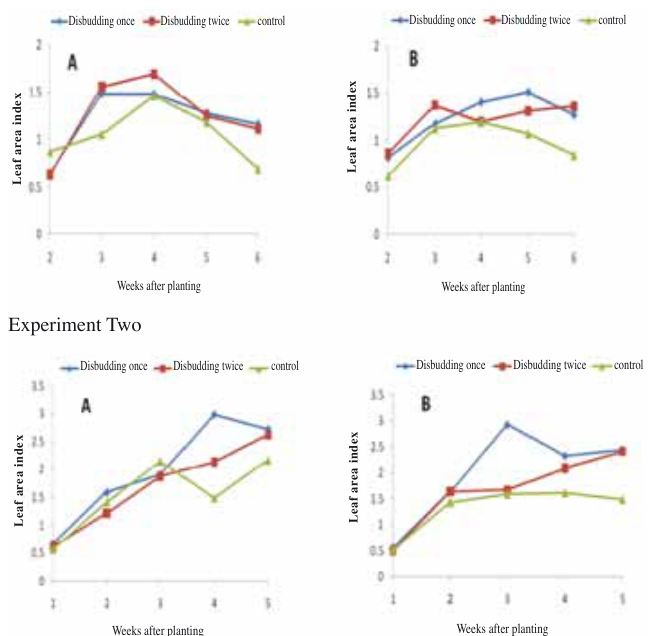
Fig. 3 - Leaf area index as affected by disbudding and cultivar: ‘Carmi - ne’ (A) and ‘Chief Gold’